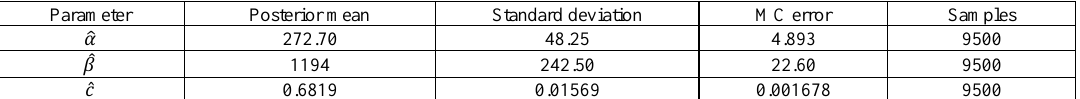
Table 7. Detail of posterior distribution for 5 th sample field degradation data.